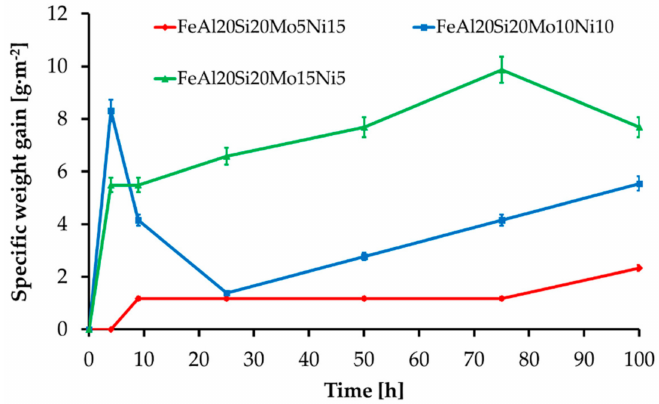
Figure 9. Oxidation kinetics of the MA + SPS FeAl20Si20-Mo-Ni alloys during annealing at 800 ◦ C.